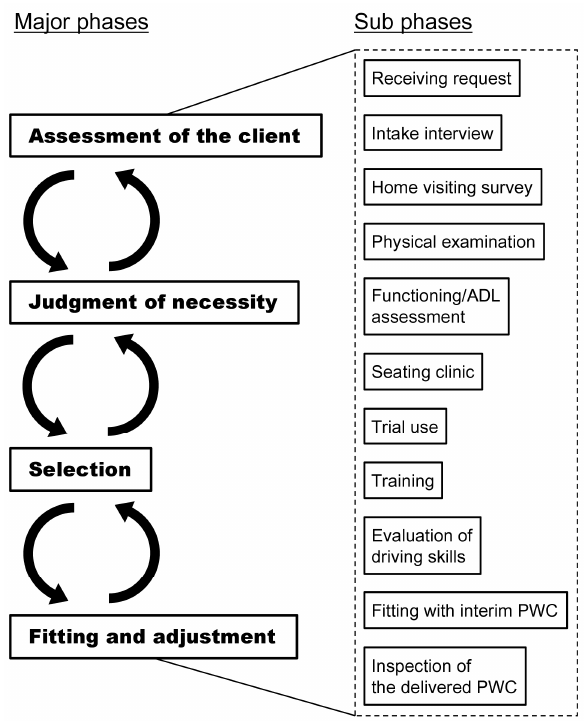
Figure 2. The ATD provision process derived from the interview. Four major phases and sub-phases are depicted.